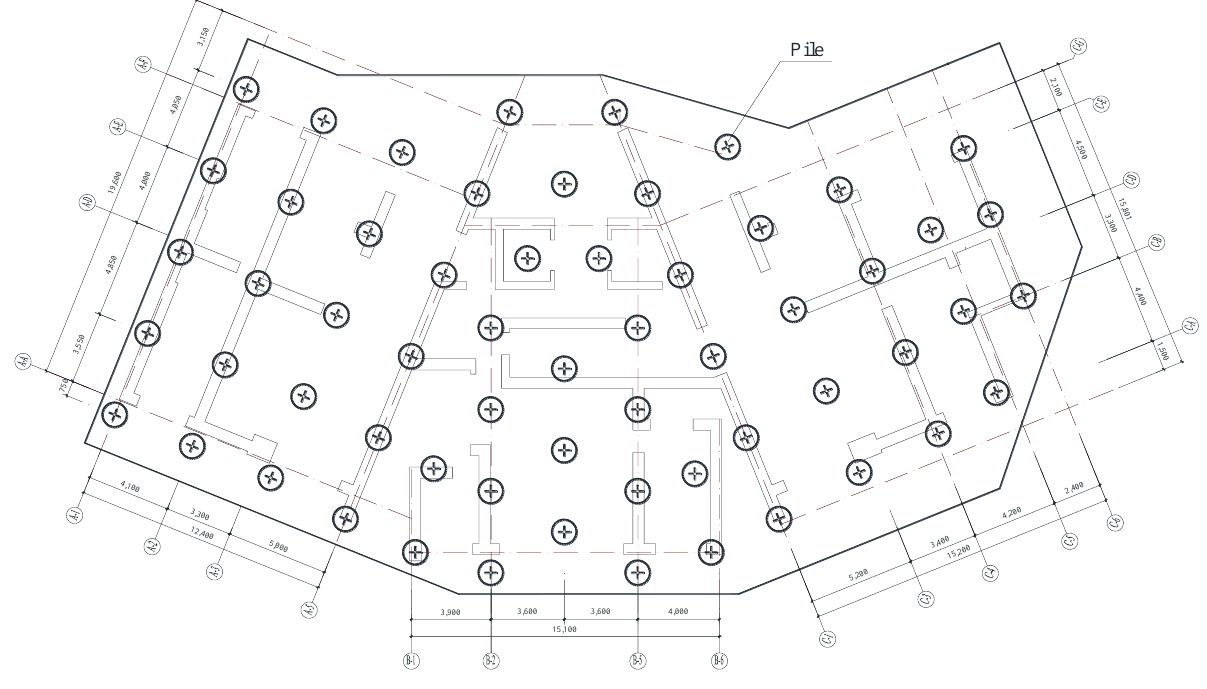
Figure 4. Plan of pile arrangement .